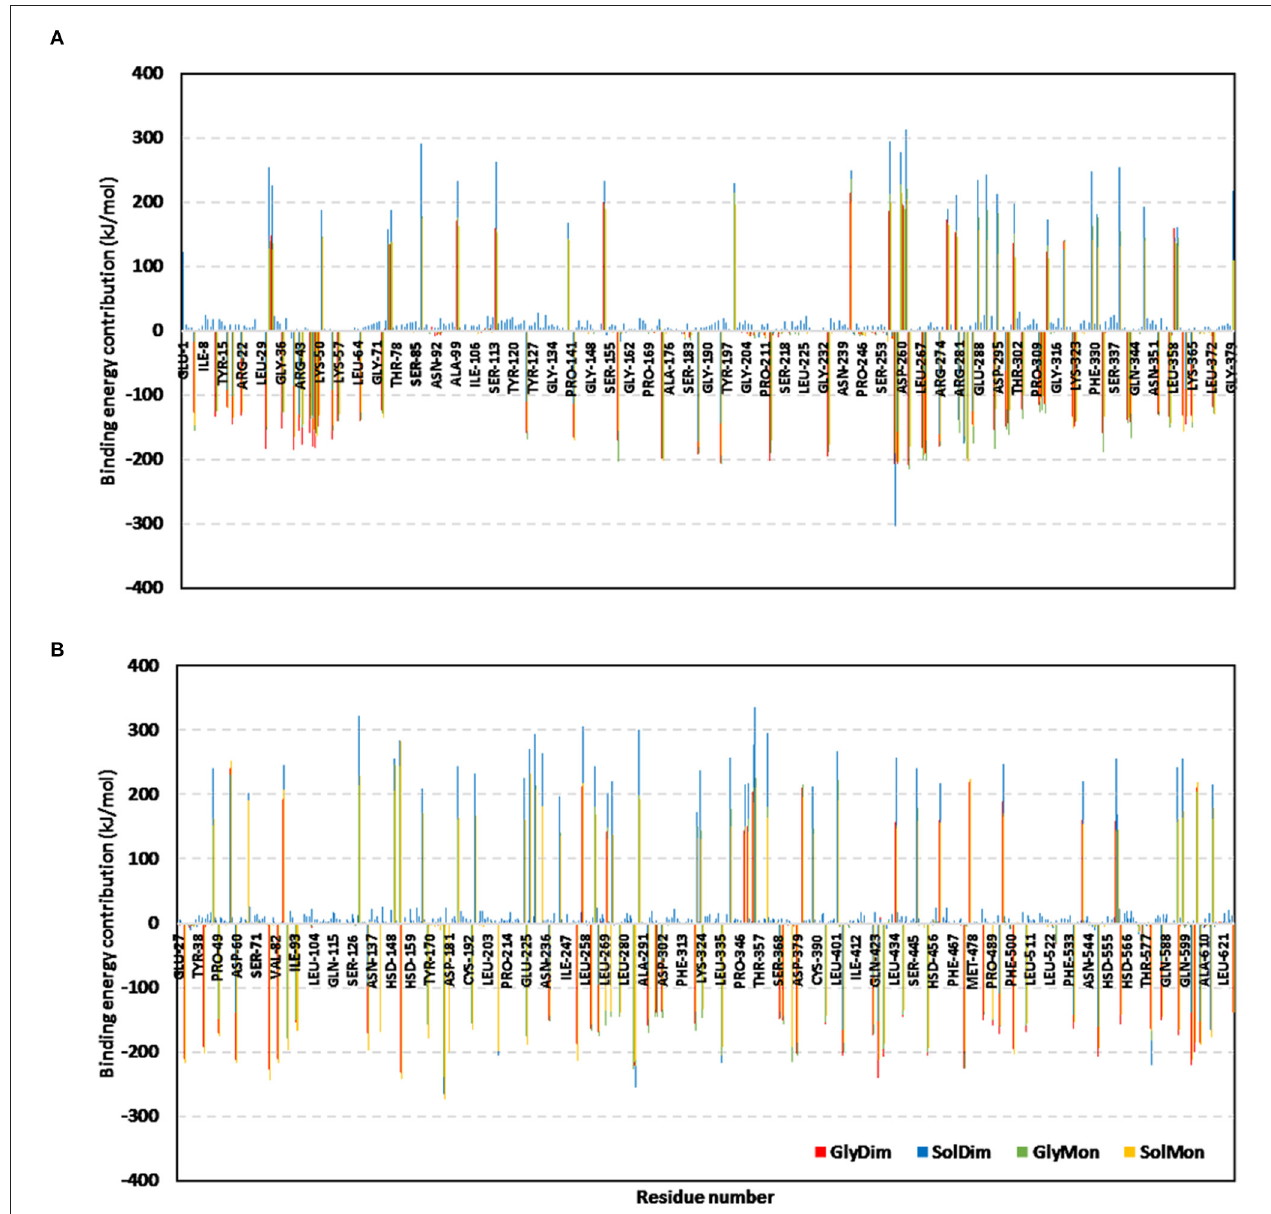
FIGURE 10 | Residue-wise binding-free energy decomposition for the simulated epitope vaccine- h TLR-4 complexes. The energy contributions in kJ/mol within the total free binding energies for the residues comprising the simulated (A) epitope vaccine; (B) h TLR-4 target proteins. Energy contributions are represented against the residue